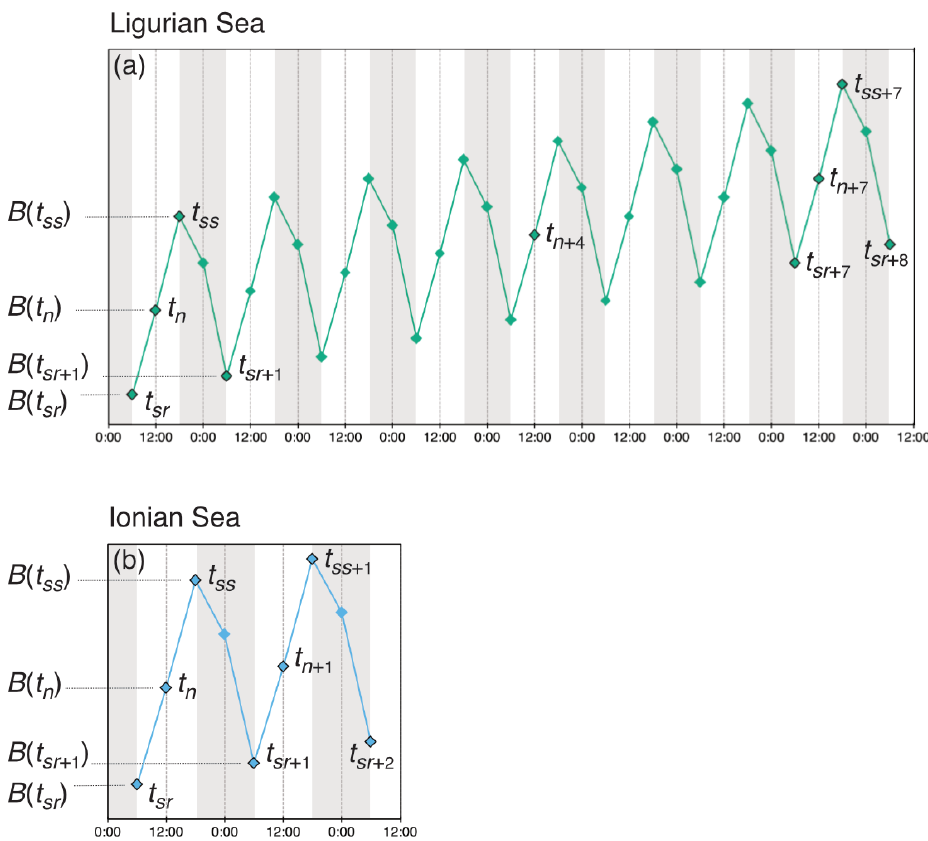
Figure 2. Schematic representation of the diel variations of the depth-integrated bio-optical properties converted to POC biomass ( B ) and the sampling strategies employed in the (a) Ligurian Sea and (b) Ionian Sea. The diamond-shaped symbols indicate schematically the float profile times, labeled with timestamps associated with sunrise (sr), noon (n), sunset (ss) and midnight (m), with the corresponding POC biomass estimated within the considered layer (e.g., B(t sr )). The numeric subscripts ( + 1, + 2, + 4 or + 5) indicate the number of days since the first profile of the summertime time